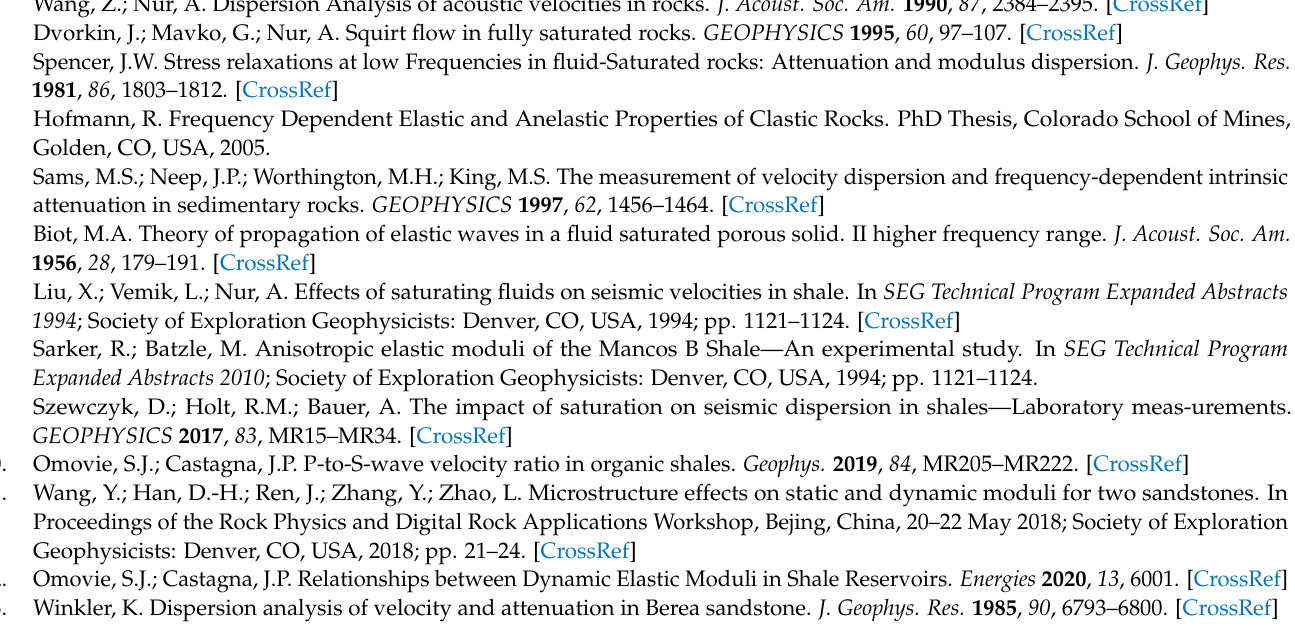
The Thomsen anisotropy parameter δ , required in Equation (A2), is given by